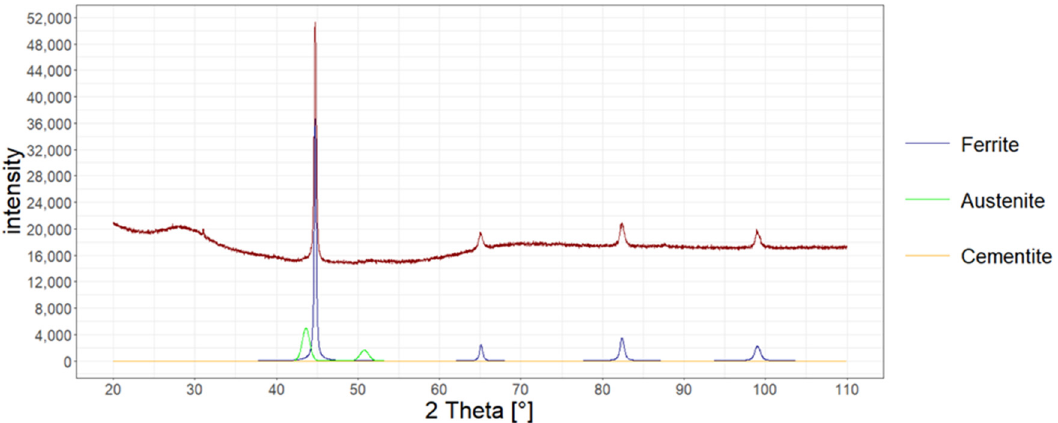
Figure 10. Phase graph of the X ‐ ray diffraction of the tested heat ‐ treated steel according to variant No. 3.